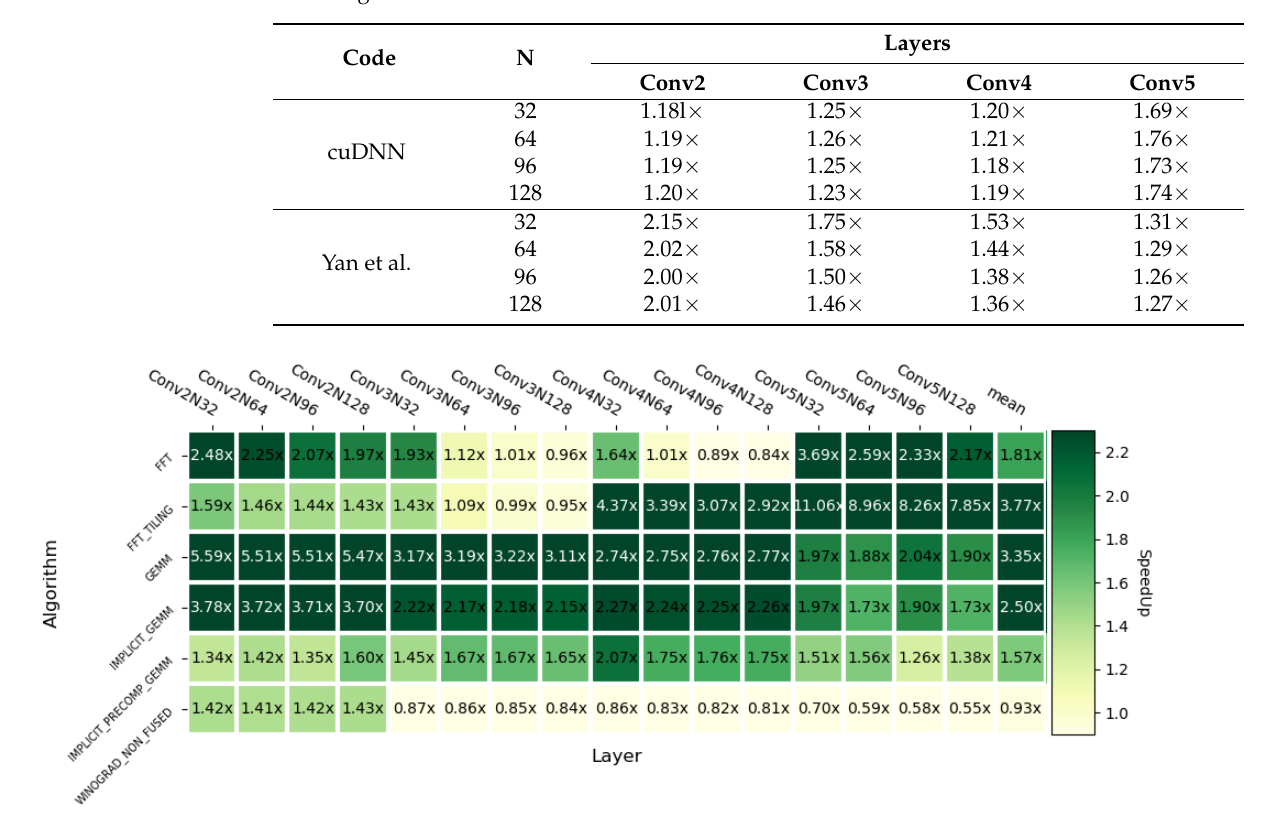
Table 3. SpeedUp. 1.34 × on average over cuDNN and 1.58x over the [10] CUDA C++ implementation on Turing RTX 2080Ti.